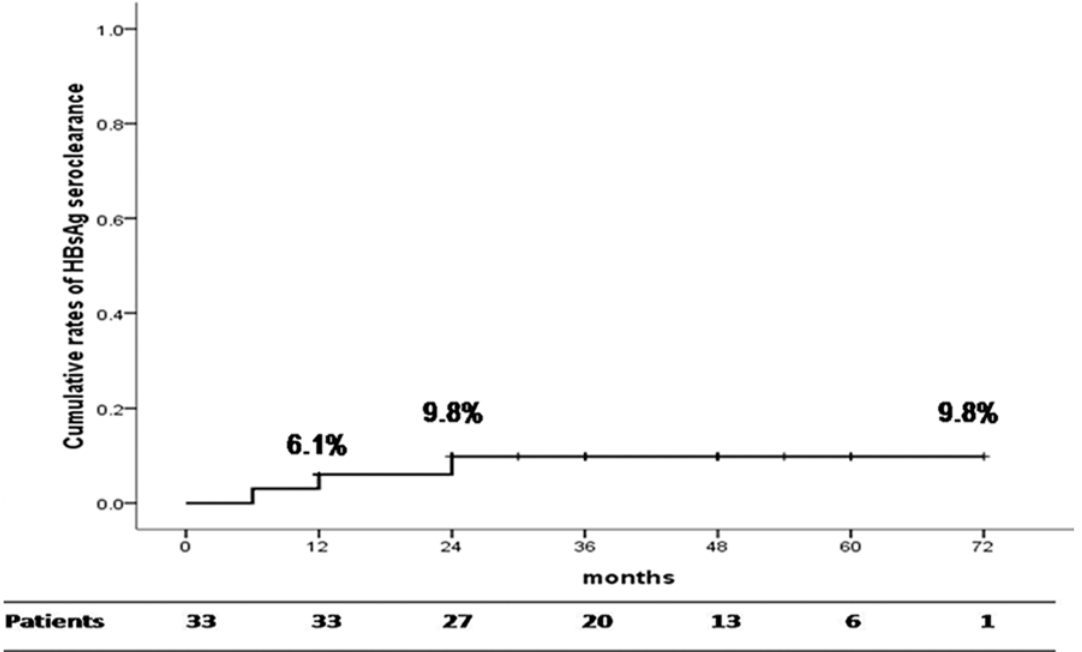
Fig 4. Cumulative rates of HBsAg loss in HBeAg-negative